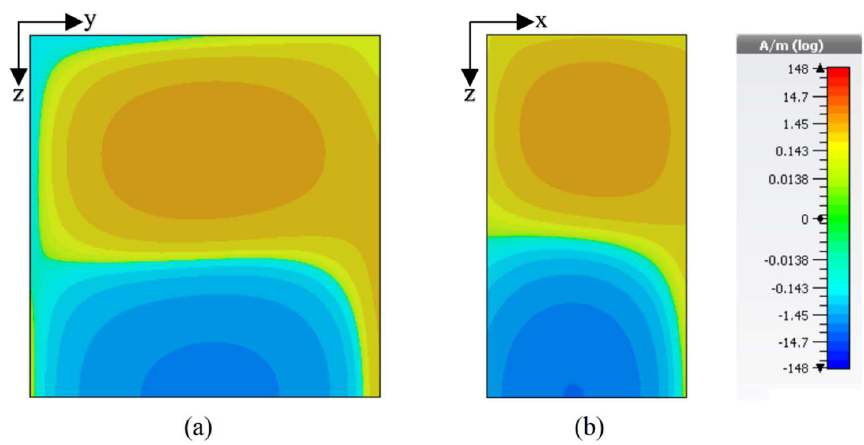
Figure 5. E-field distribution of the CP 5G RDRA ( a ) TE (cid:2964)(cid:2869)(cid:2871)(cid:2934) at 4.13 GHz; ( b ) TE (cid:2869)(cid:2964)(cid:2871)(cid:2935) at 4.52 GHz.